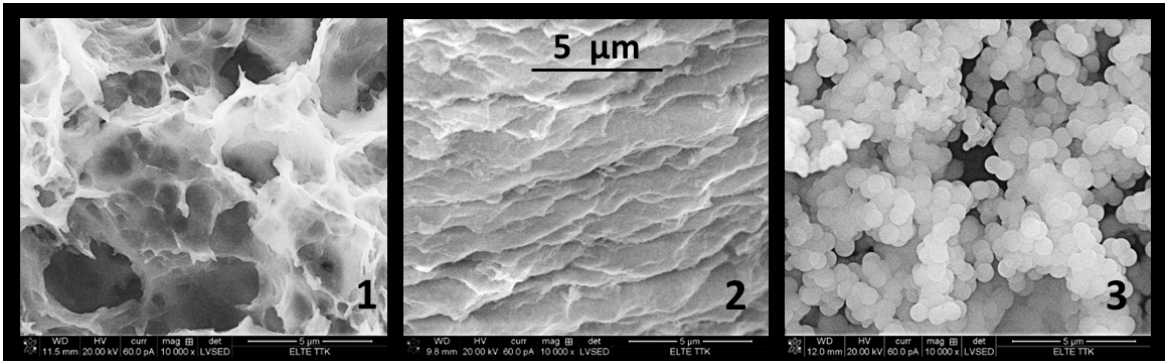
Figure 1. SEM images of silica cryogels from TEOS. Silica cryogel 1 is prepared from optimized composition (1:4:3) of TEOS, ethanol/water, and HNO 3 . Silica cryogel 2 is catalysed by citric acid; cryogel 3 by ammonia. The magnification is 10,000× in every image. Table 1. The effect of preparation conditions on the porous structure derived from TEOS. Molar Ratio of Solvent/Si